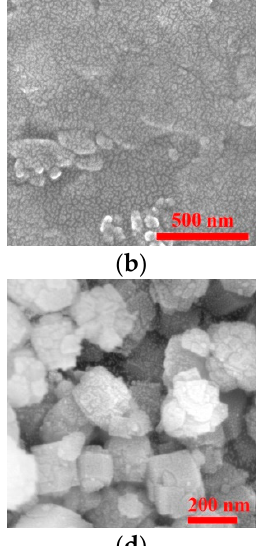
Figure 2. SEM images of carbon materials obtained by removals of silica and titania from CSTs ( a ) and CSTd ( b ) with hydrofluoric acid aqueous solution, HTS-1s ( c ), and HTS-1d ( d ).